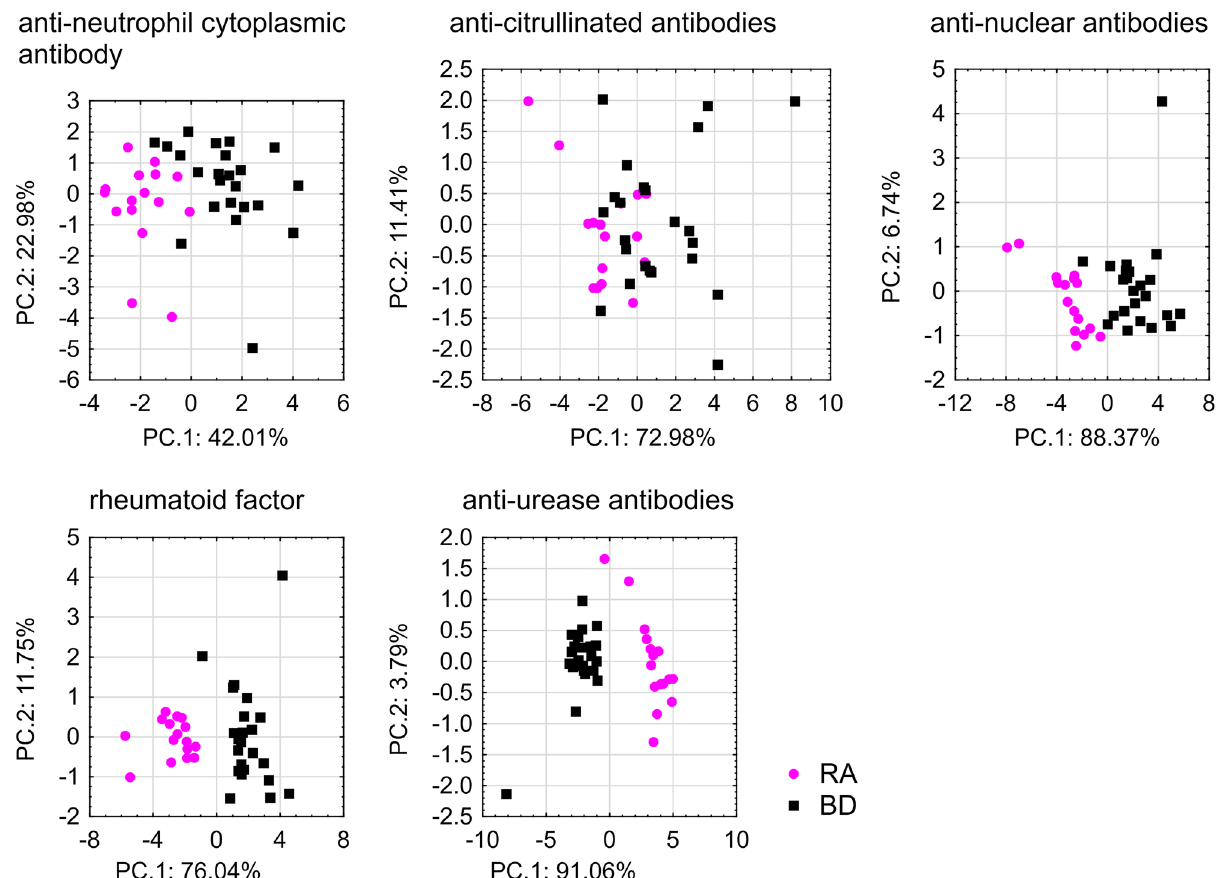
Figure 3. PCA scatter plot displaying the separation of rheumatic arthritis patients and healthy blood donors. ATR band positions wave number cm